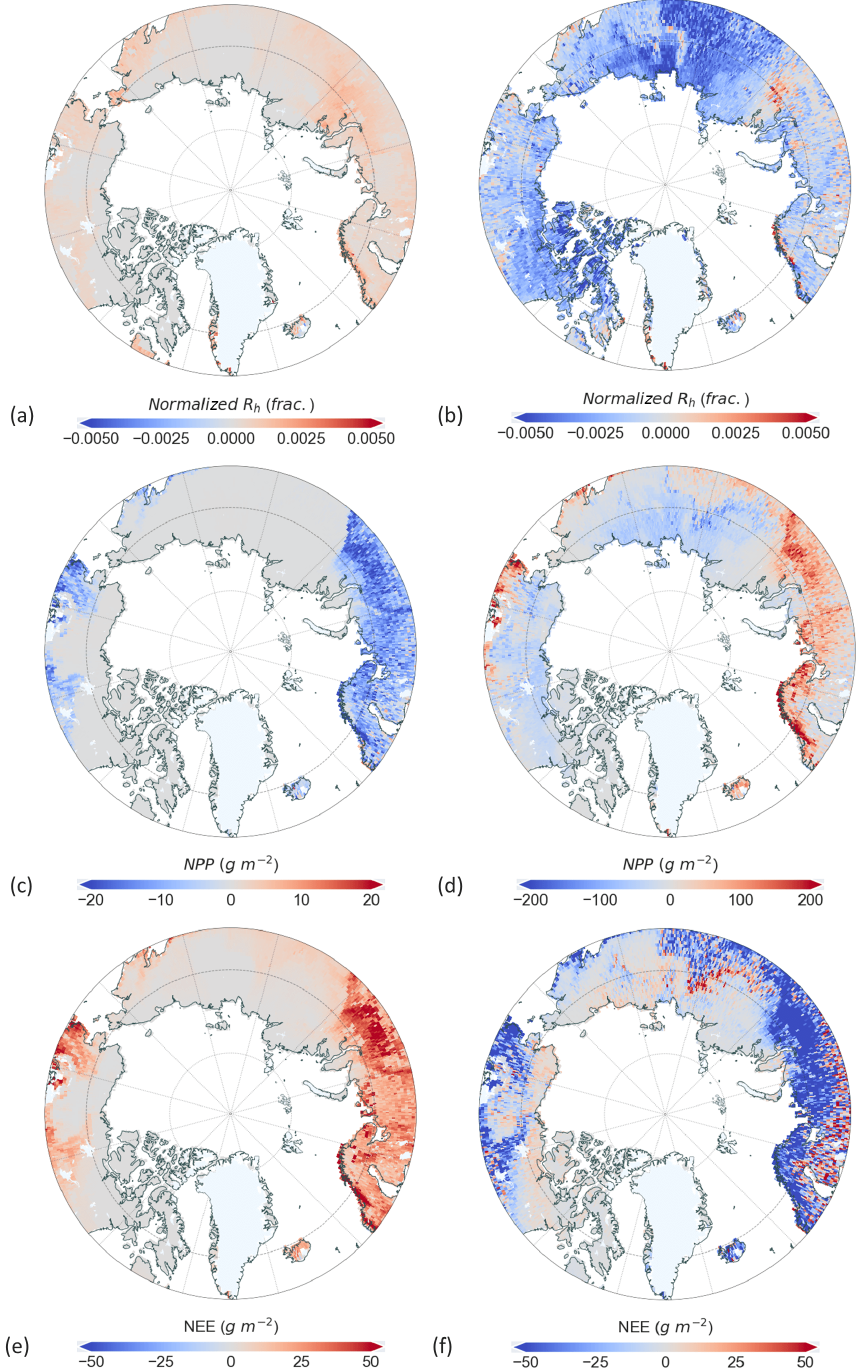
Figure 10. The difference in normalized heterotrophic respiration for winter (a) and summer (b) between the two schemes. Differences between simulated Dynamic and Static winter (c) and summer (d) NPP. Differences between simulated Dynamic and Static winter (e) and summer (f) NEE. Differences are calculated by subtracting the Static from Dynamic simulation outputs. Simulations for the two schemes are shown in Figs. S5 (heterotrophic respiration), S6 (NPP), and S7 (NEE) in the